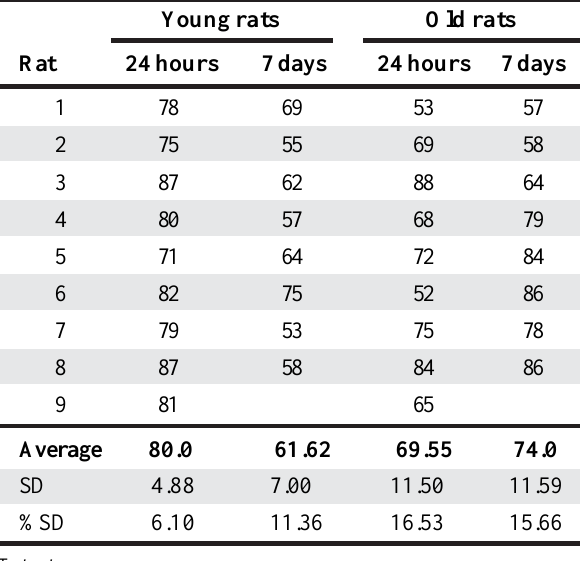
FIGURE 2 - Average of mitotic figures in 5 TABLE 3 - Average of PCNA-positive nuclei